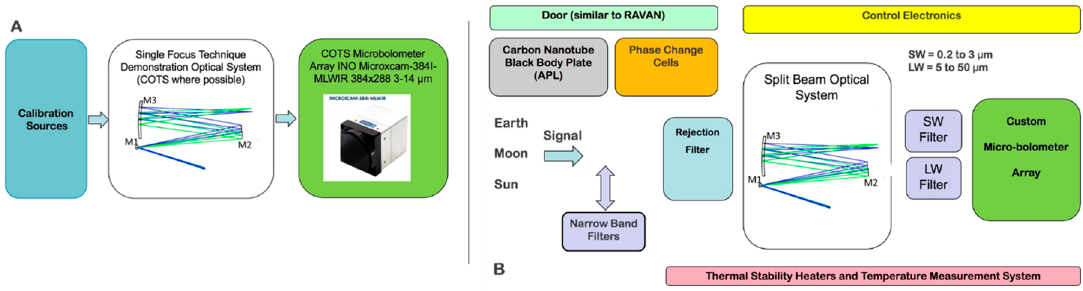
Figure 6. ( A ) The Trutinor Breadboard diagram; ( B ) The Trutinor EDU system block diagram. Figure 6. ( A ) the Trutinor Breadboard diagram; ( B ) the Trutinor EDU system block